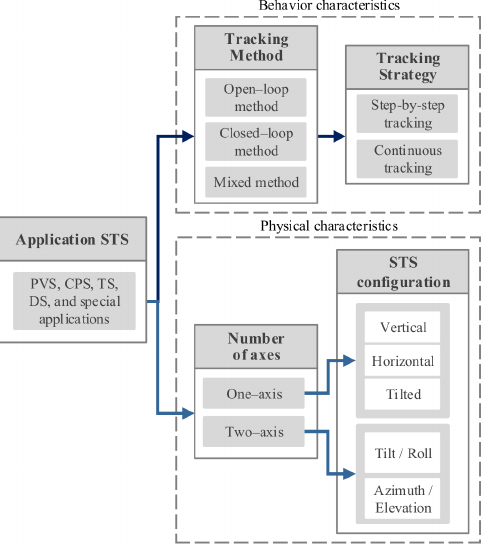
Figure 2. Classification of the characteristics of Solar Tracking